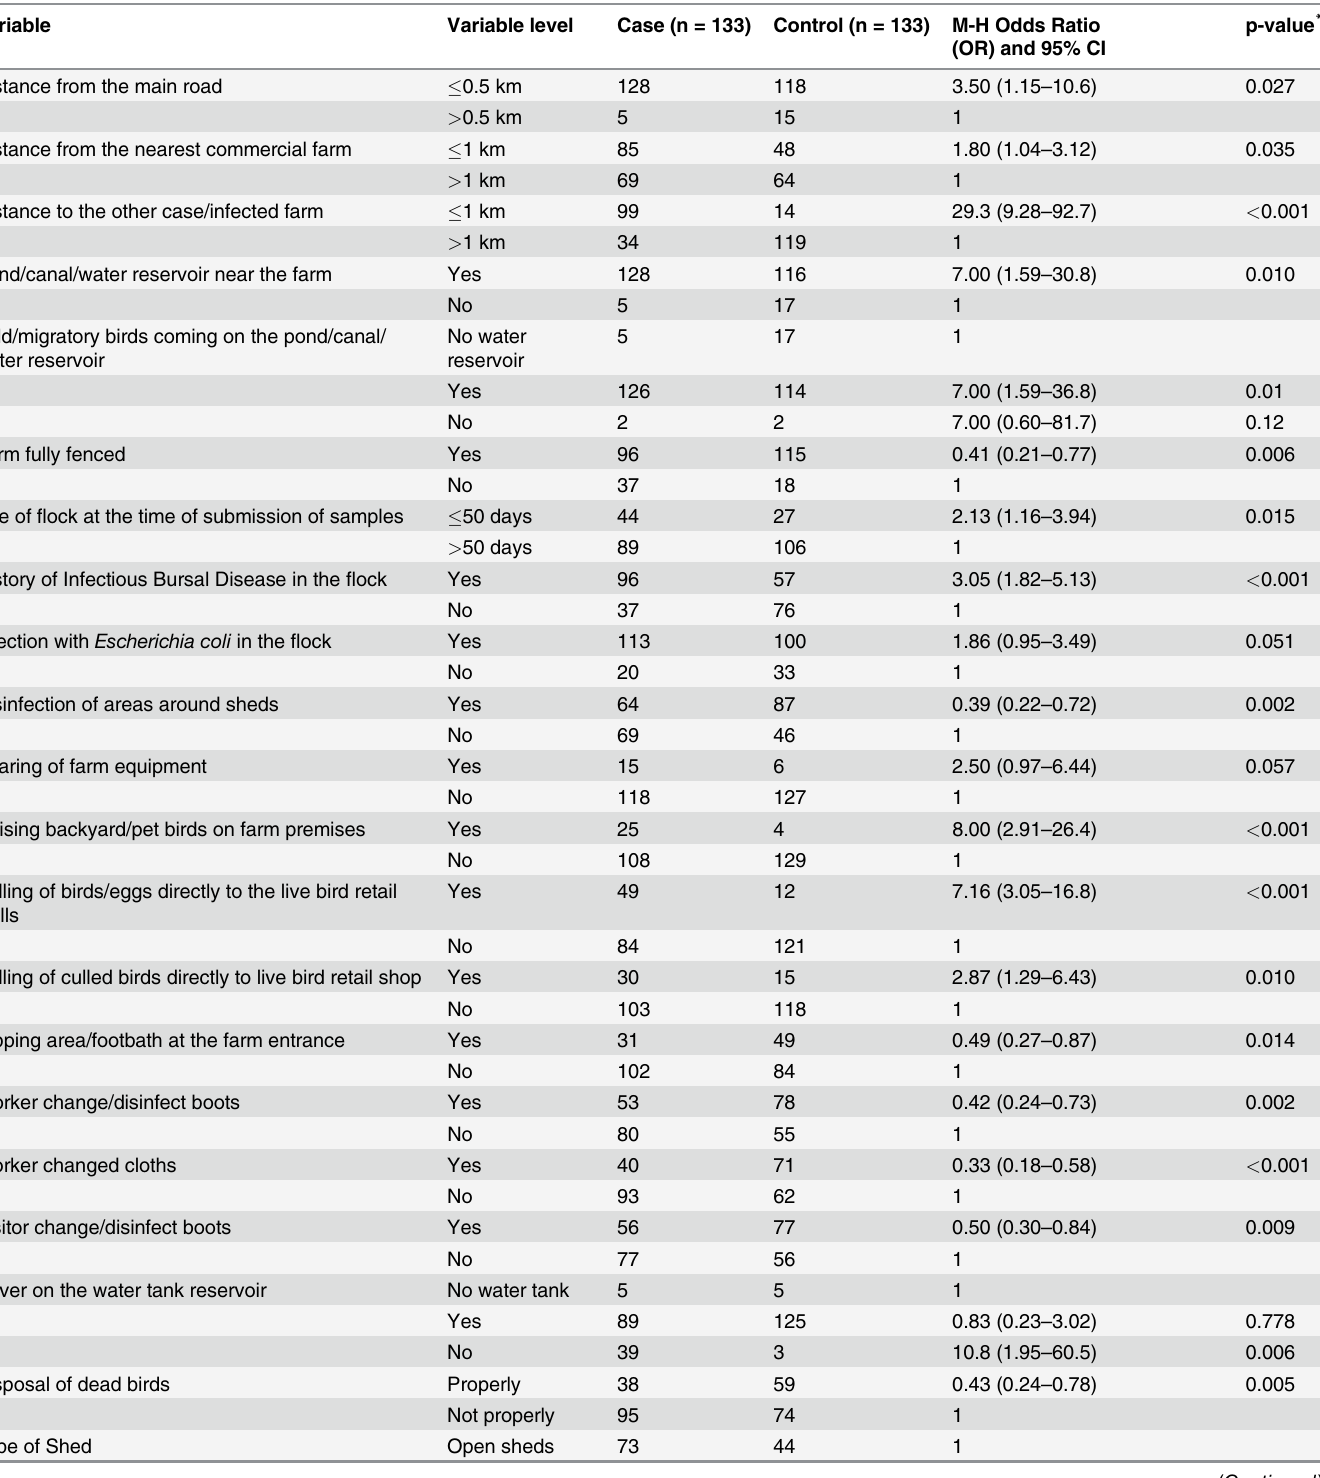
Table 1. Result of univariable analysis by Mantel-Haenszel matched pair analysis of the possible risk factors associated with the risk of AIV H9N2 infection among commercial poultry farms.